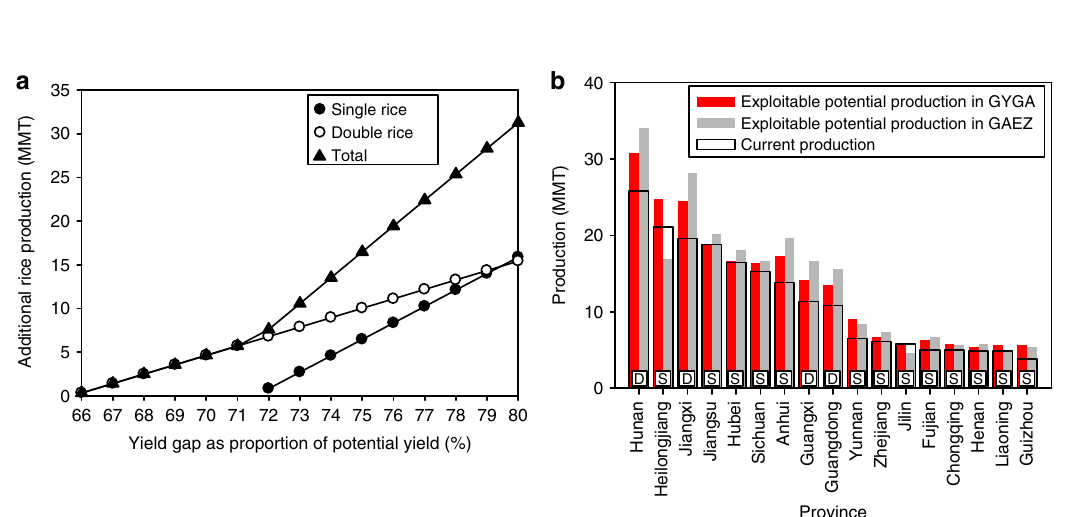
Fig. 3 Rice production in different cropping systems and provinces. a Additional rice production resulting from yield gap closure (expressed as % of potential yield) in single- and double-rice systems assuming no change in harvested area for each system and a maximum exploitable yield ceiling that is 80% of potential yield. b Current annual rice production and exploitable potential production for each major rice-growing province as estimated using protocols developed by the Global Yield Gap Atlas (GYGA) or by the Global Agro-Ecological Zones Model version 3.0 (GAEZ v3.0). Capital letters at bottom of each province production bar designate provinces in which double- (D) or single-rice (S) dominate. Exploitable potential production for each province is calculated as the product of provincial average rice planting area of 2013 – 2015 and the exploitable yield whereby all rice farmers achieve yields that are 80% of potential yield. The current production for each province is based on 2013 – 2015 average. MMT million metric tons. Source data